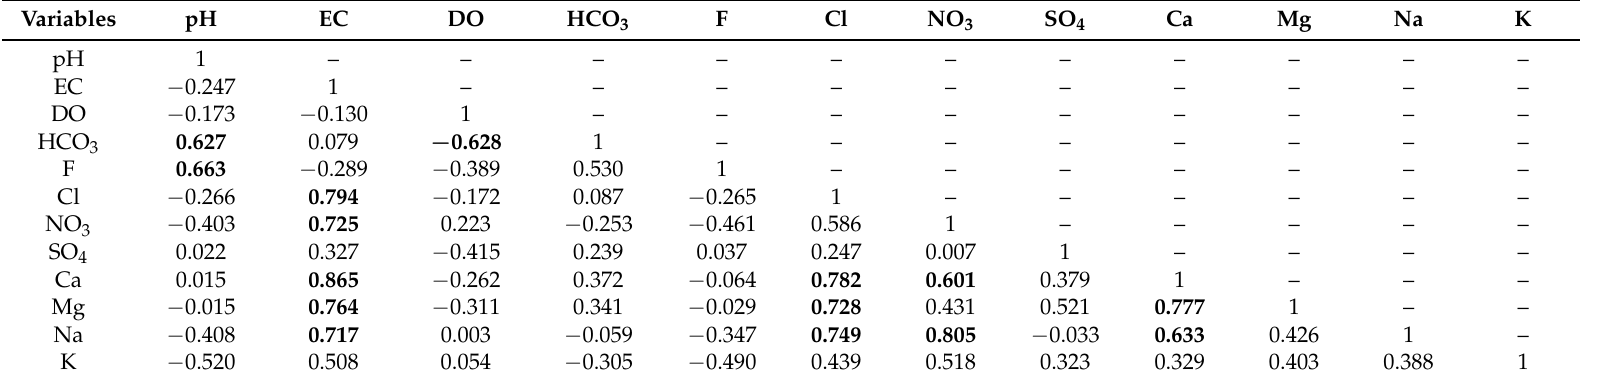
Table 2. Spearman’s rank correlation coefficients between measured